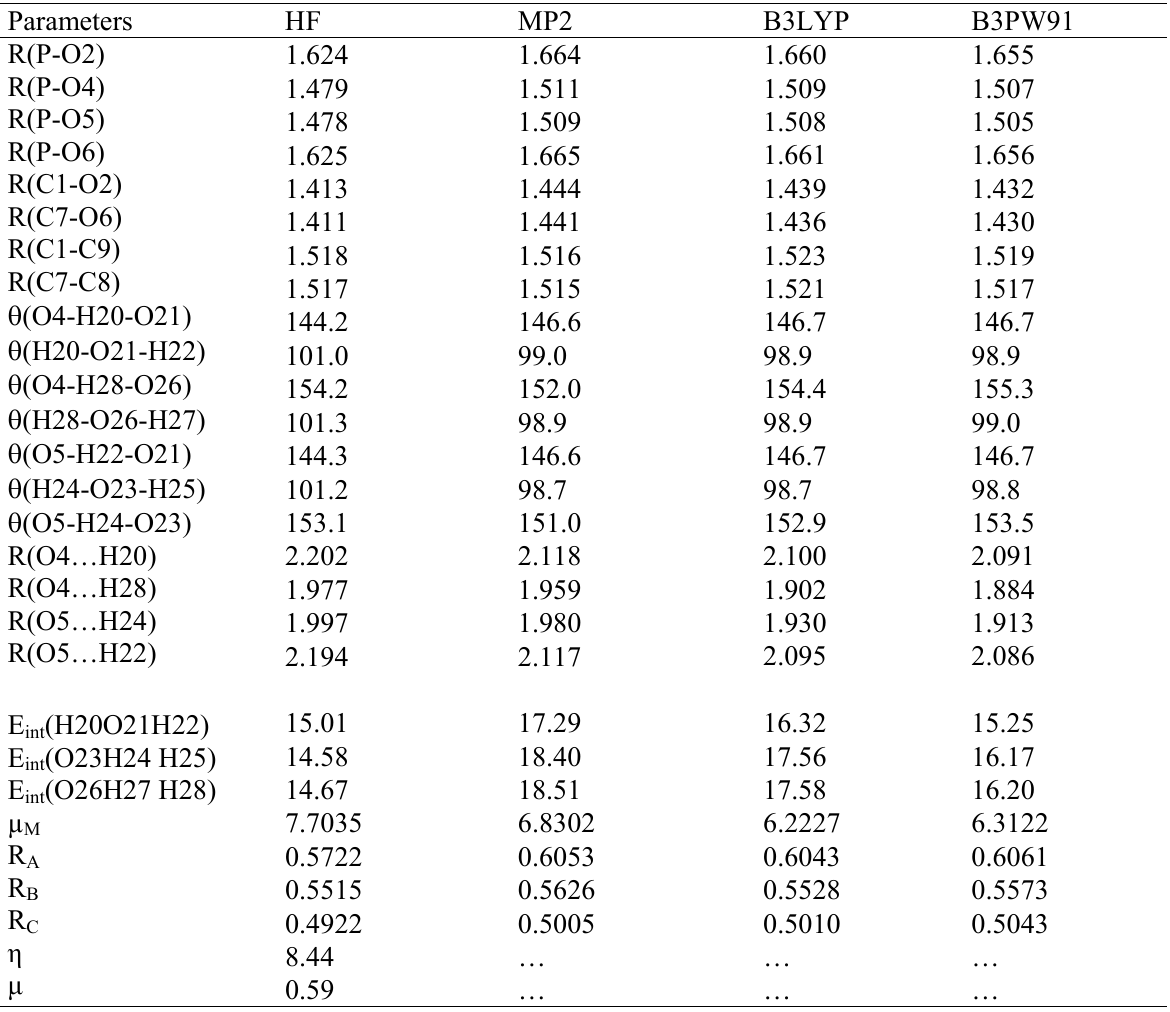
Table 7 Optimized geometrical parameters (bond length in Å, bond angle in degrees), rotational , R , R (in GHz), dipole moment µ constants R A B C chemical hardness η (in eV) for DEP-3 water